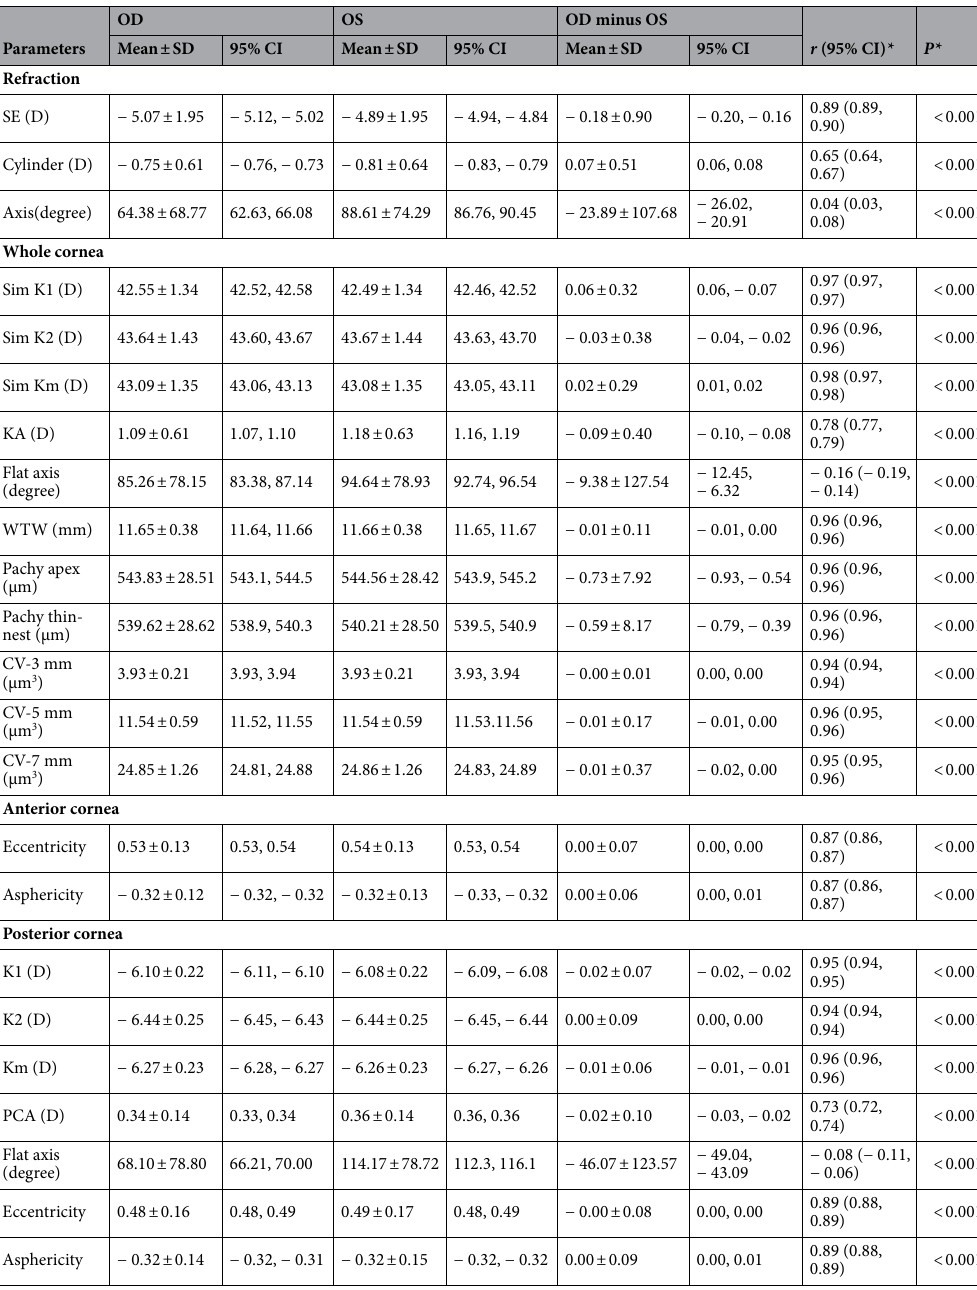
Table 2. Summary of the corneal biometrics in both eyes. SD standard deviation; CI confidence interval; SE spherical equivalent; D diopter; KA keratometric astigmatism; WTW white-to-white; CV corneal volume; PCA posterior corneal astigmatism. *Correlation coefficient and p value of the Spearman’s correlation